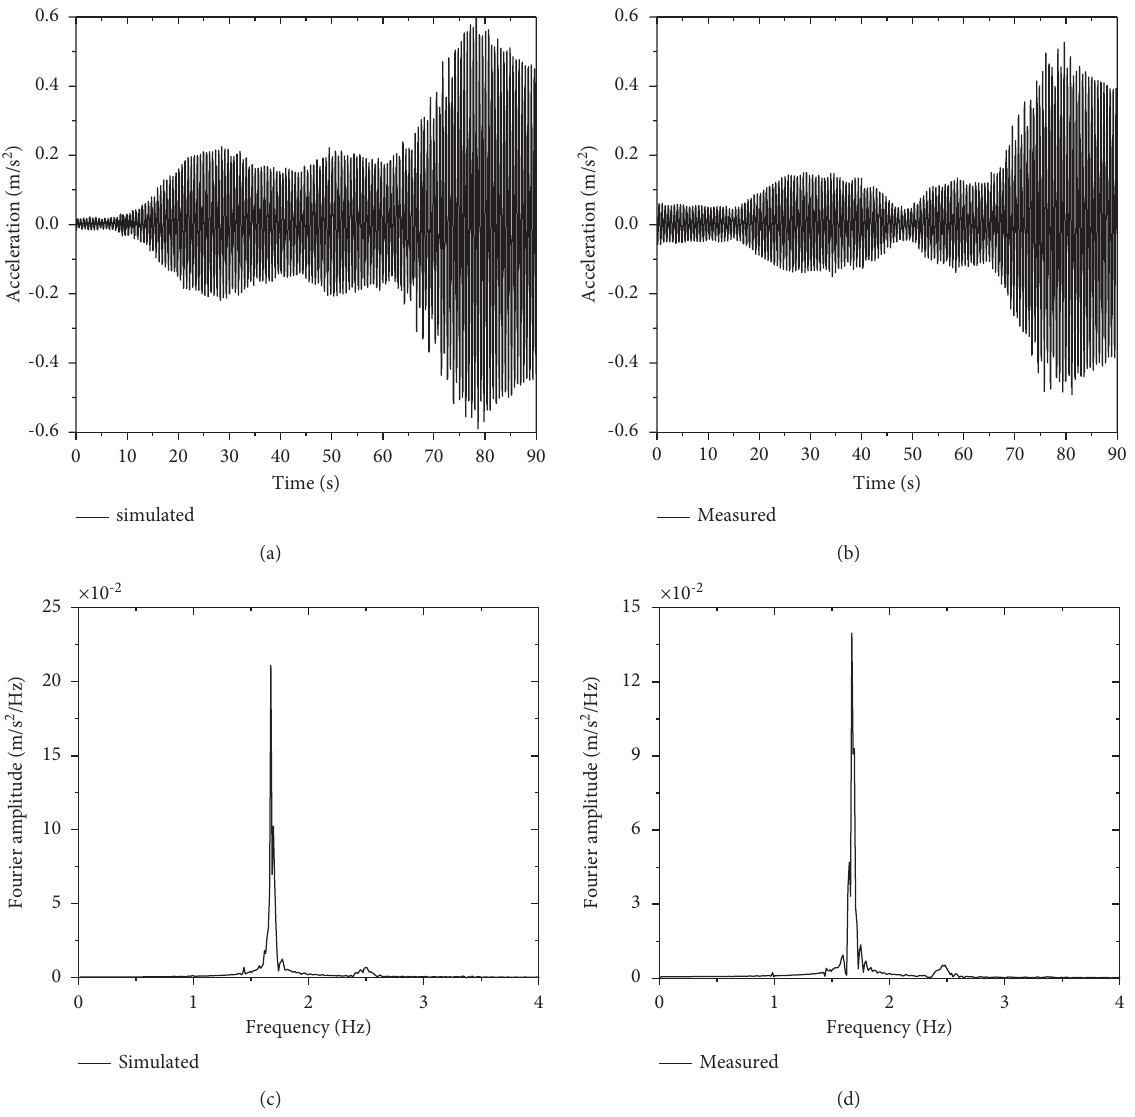
Figure 21: Comparison between simulated and measured bridge acceleration at the center of side span: (a) simulated time history; (b) measured time history; (c) simulated spectrum; (d) measured